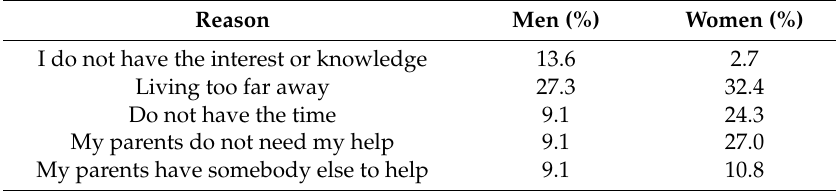
Table 6. Reasons for having no ambition to take over the forest estate according to